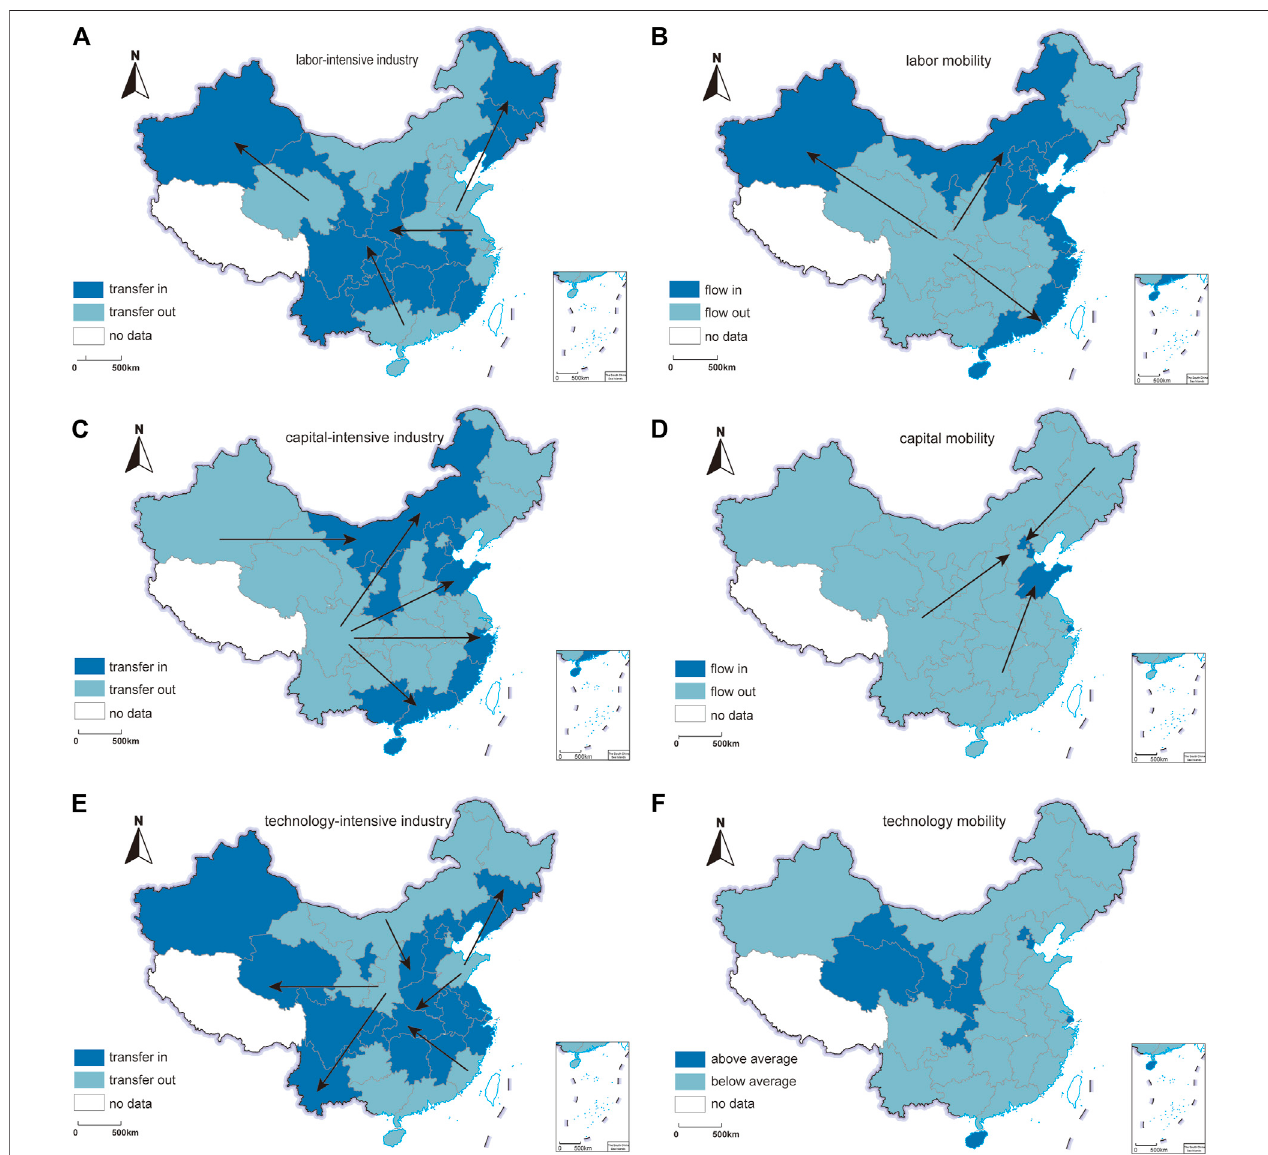
FIGURE 2 | The spatial layout of factor mobility and industrial